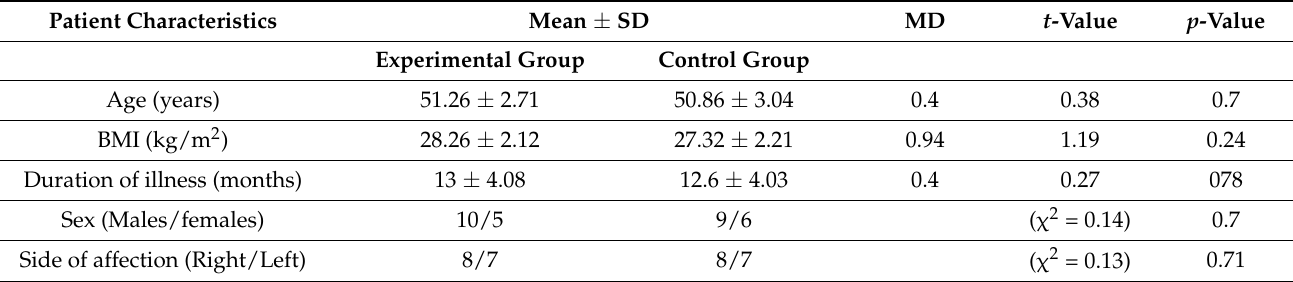
Table 1. Patient characteristics in the control group (GI) and intervention group